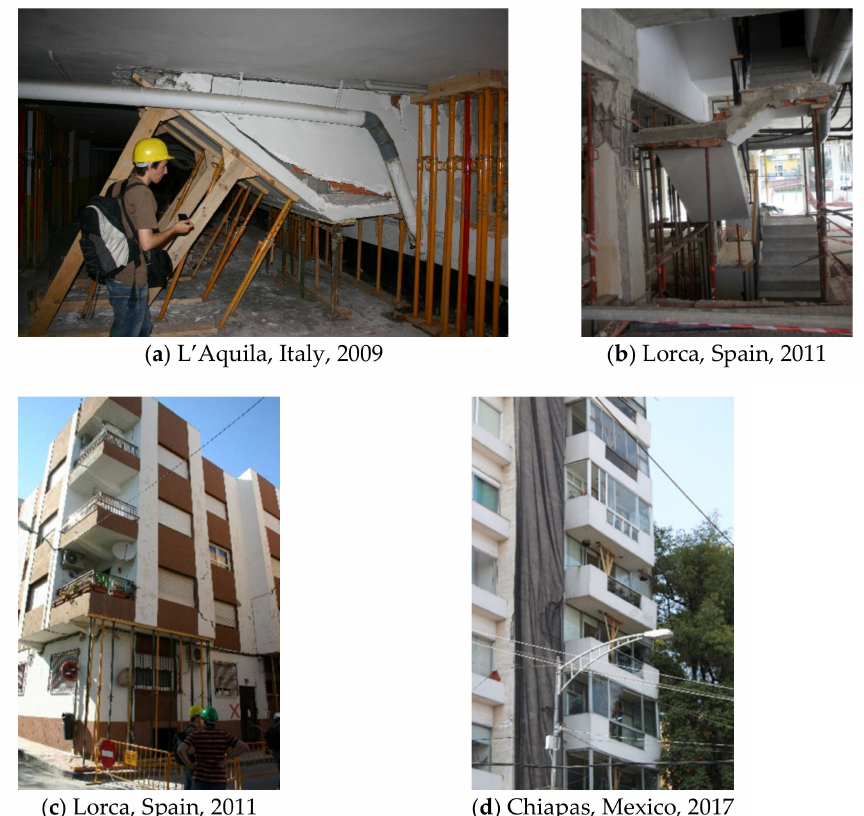
Figure 17. Damage type 9—damage in secondary elements: ( a ) partial collapse of the stairs; ( b ) absence of proper connection between the stairs and the primary structural-resistant system; ( c ) excessive deformation of the cantilever—general view ( d ) use of props to support the cantilevers with excessive deformation.